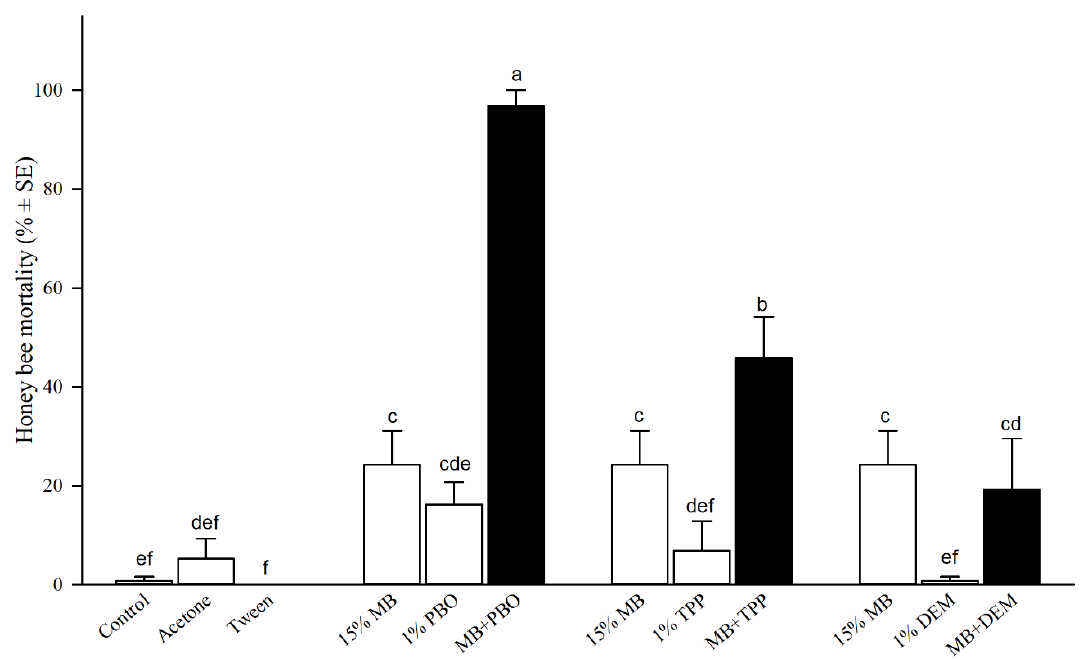
Figure 1. Examination of major enzymes on detoxifying methyl benzoate (MB) in honey bees using piperonyl butoxide (PBO: Inhibits P450 oxidase), triphenyl phosphate (TPP: Inhibits esterase), or diethyl maleate (DEM: Inhibits glutathione S-transferase). Mean bars with the same letters at the top of error bars indicate no significant difference between treatments ( p > 0.05). The treatment of 15% MB was reused for side-by-side graphical comparison within each of three inhibitor groups.